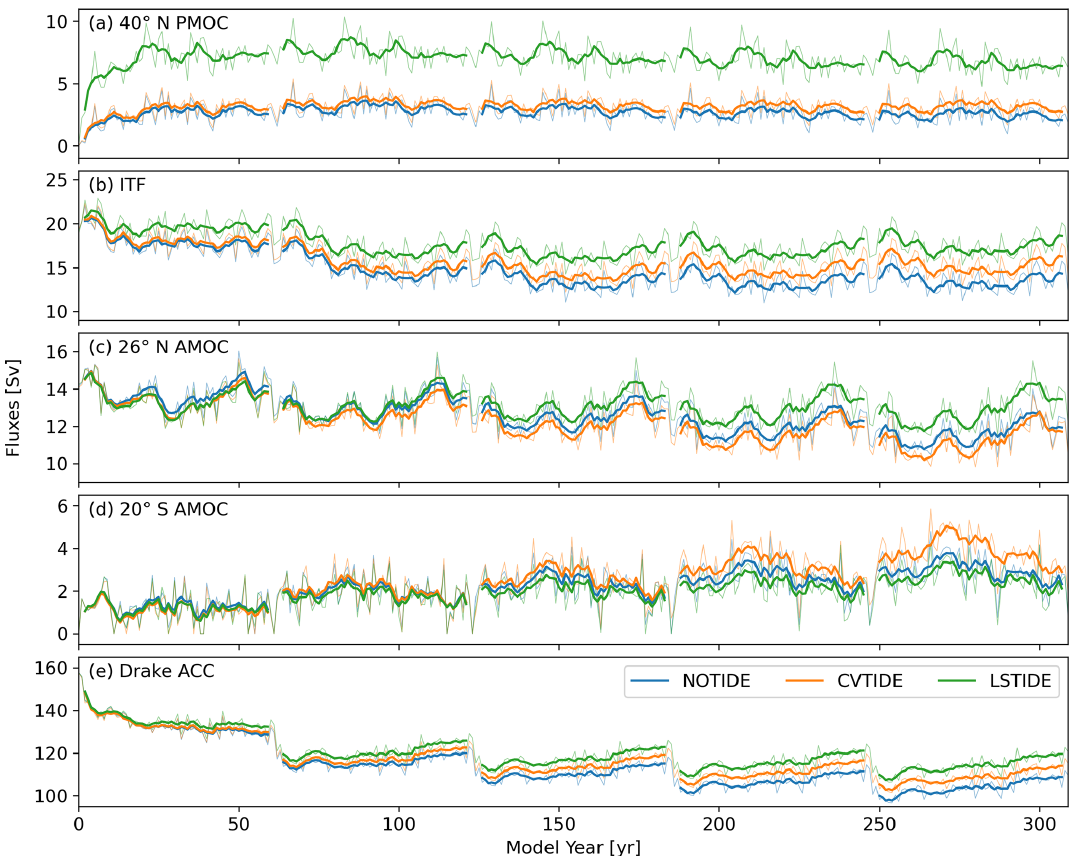
Figure 12. The time series of (a) 40 ◦ N PMOC, (b) ITF, (c) 26 ◦ N AMOC, (d) 20 ◦ S AMOC and (e) ACC through the Drake Passage from the three sensitivity runs in all five cycles. The light and thin lines are original annual time series, and the dark and thick lines are 5-year moving average results for each cycle. Note that 26 ◦ N AMOC and 20 ◦ S AMOC denote the strength of the AMOC upper cell and lower cell, respectively. The calculation of ITF and ACC flux through the transects in the Indonesian Archipelago and the Drake Passage applies the algorithm introduced in Sidorenko et al.